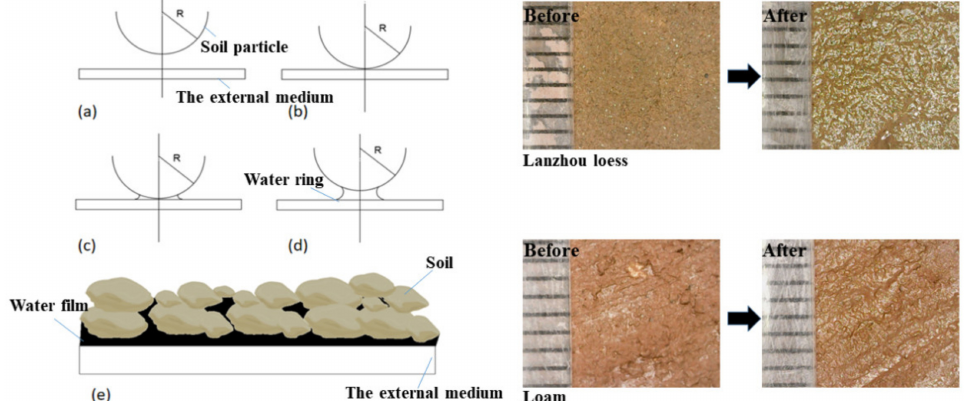
Figure 12. Water ring–water film model and soil micro-variation diagram. ( a , b )Water ring was not formed; ( c , d ) formation of the water ring; ( e ) continuous water film